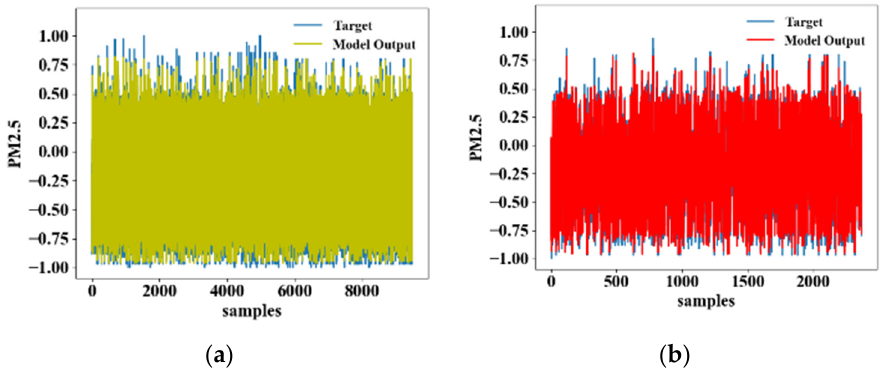
Figure 14. Learning results of the multilayer perceptron model: ( a ) training set and ( b ) testing set.